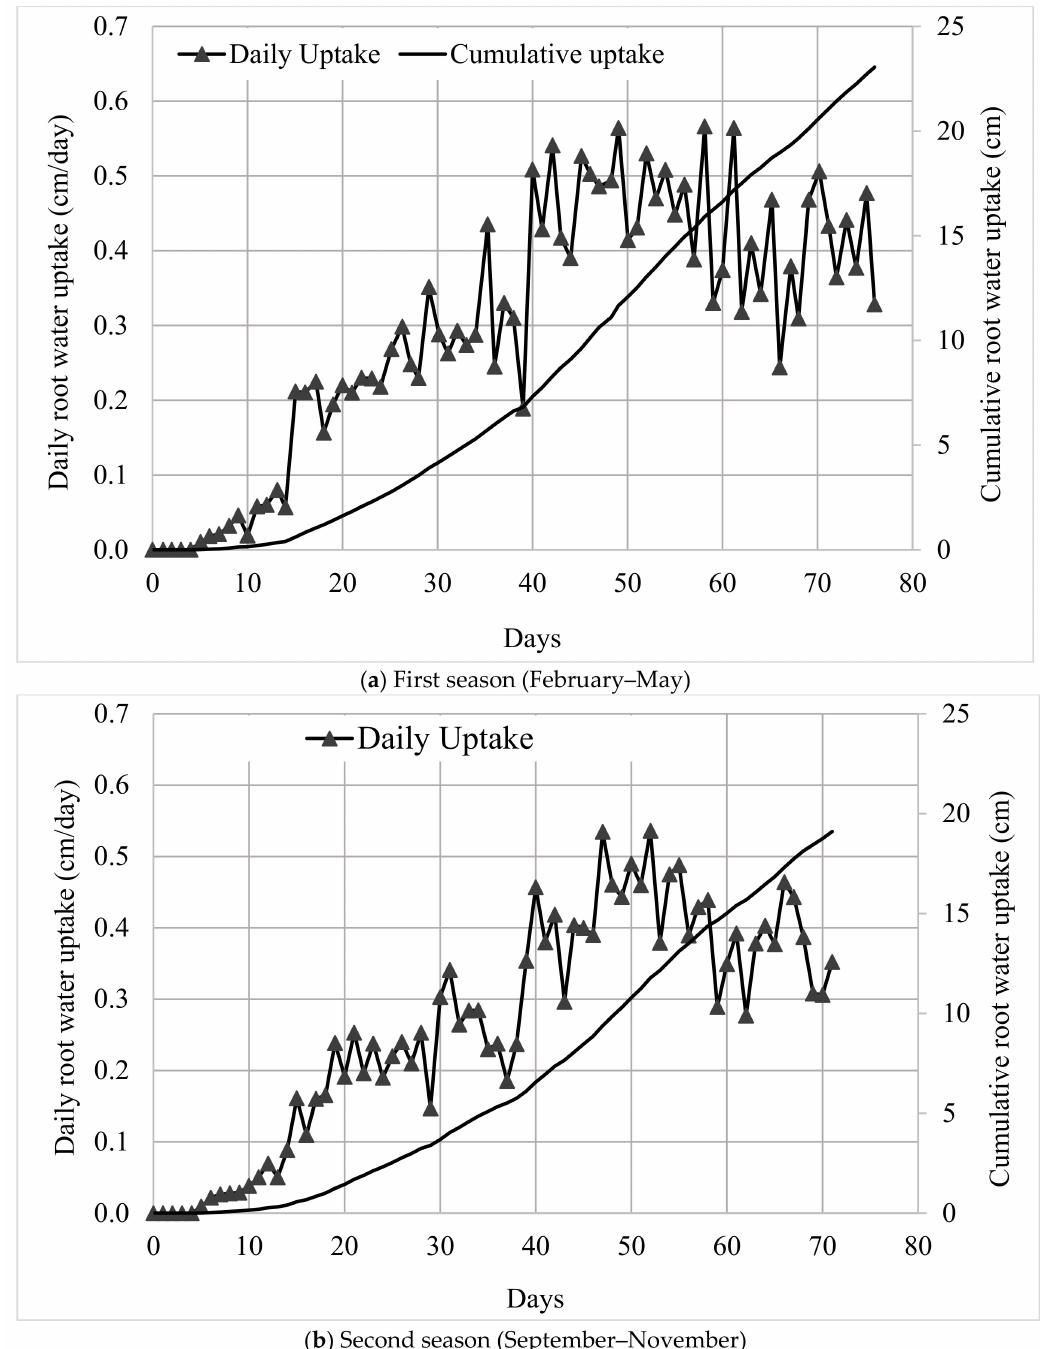
Figure 9. Simulated daily and cumulative root water uptake during two growing